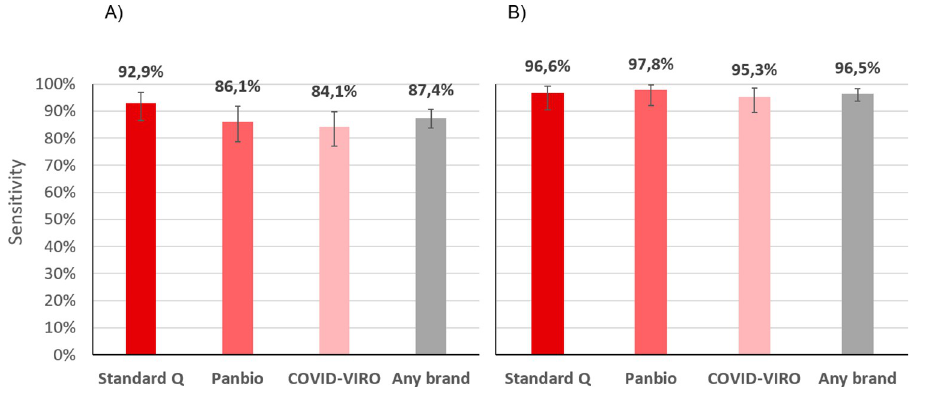
Fig 3. Sensitivity of three brands of antigen RDT compared to nasopharyngeal PCR. A) all positive patients; B) positive patients with viral loads � 10 6 copies/ml (supposedly significantly contagious).